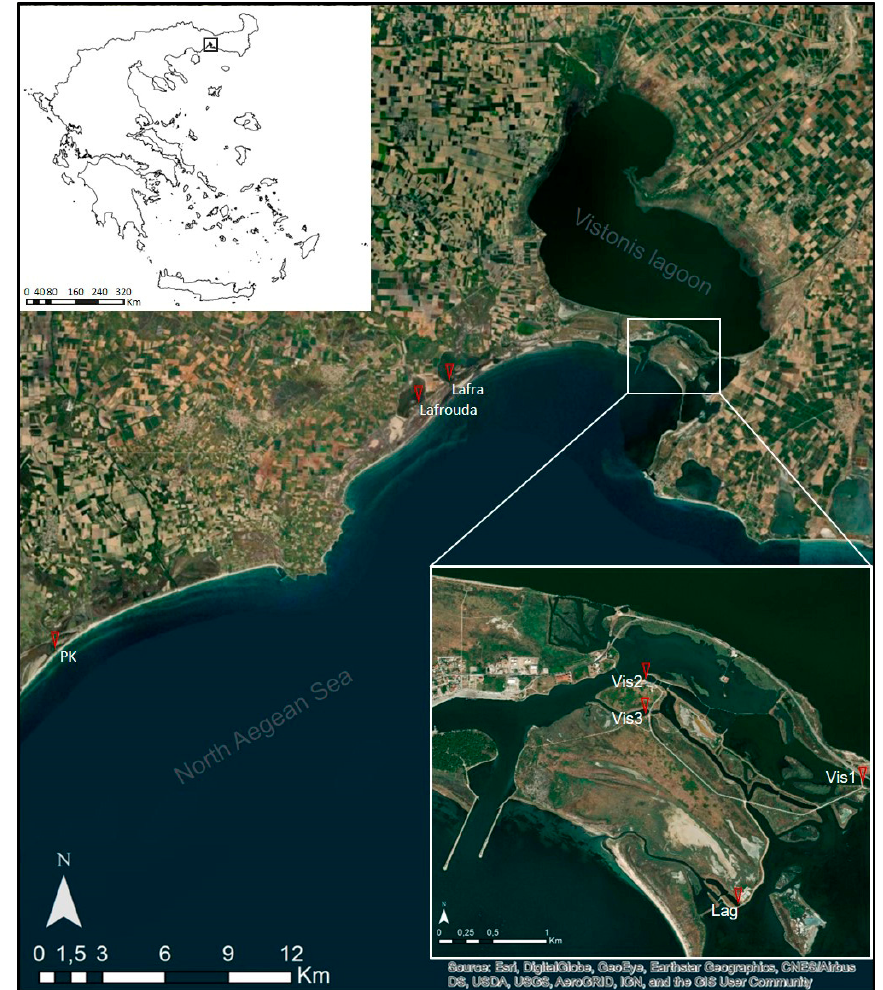
Figure 1. Study area and sampling sites in Lafra, Lafrouda, Lagos (Lag), Palaia Koiti (PK) and Vistonis (Vis1, Vis2, Vis3) lagoons. The sampling sites are indicated with a red symbol.